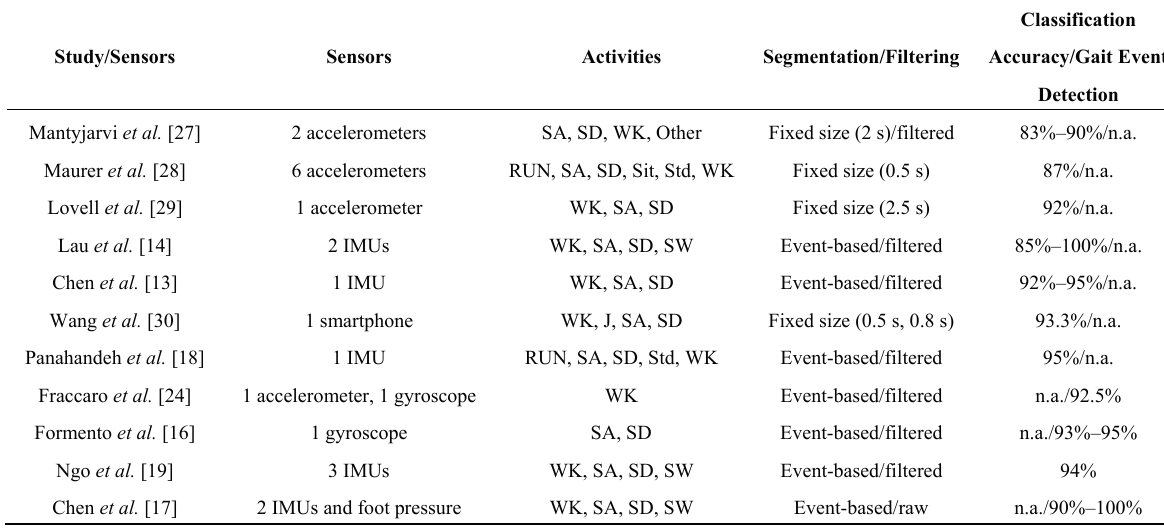
Table 1. Studies on different pre-processing